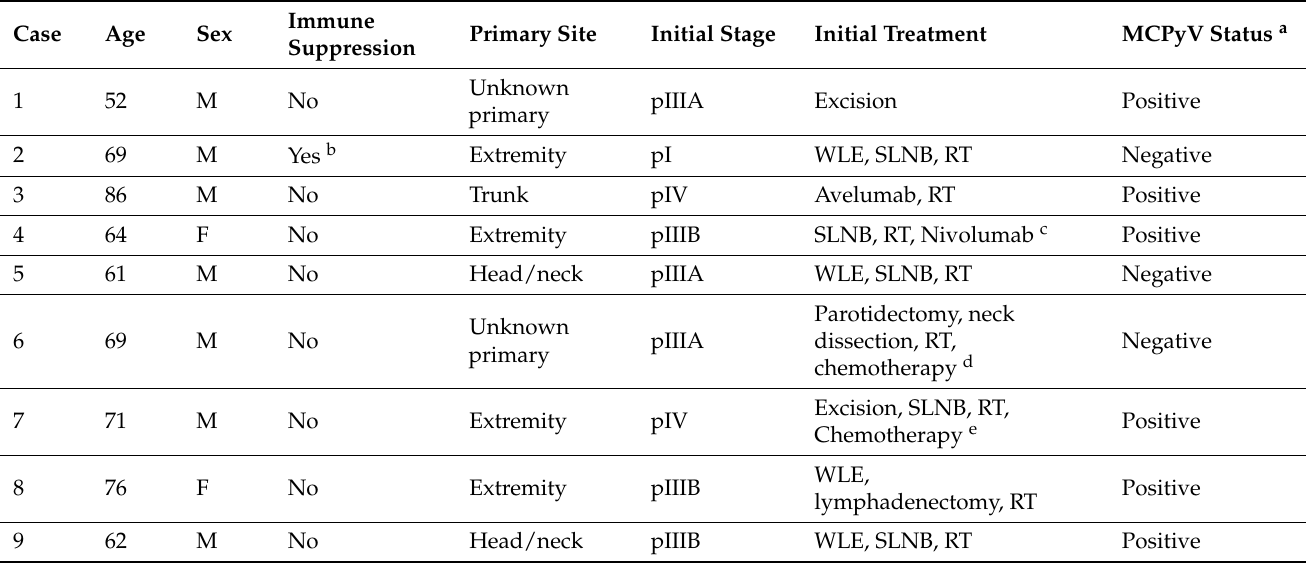
Table 1. Patient, pathologic, and treatment characteristics at initial Merkel cell carcinoma